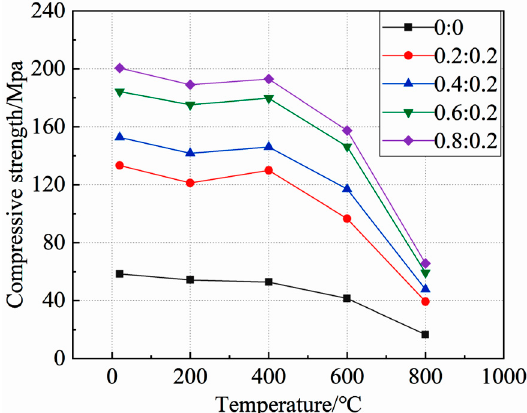
Figure 6. Relationship between concrete static compressive strength and temperature.